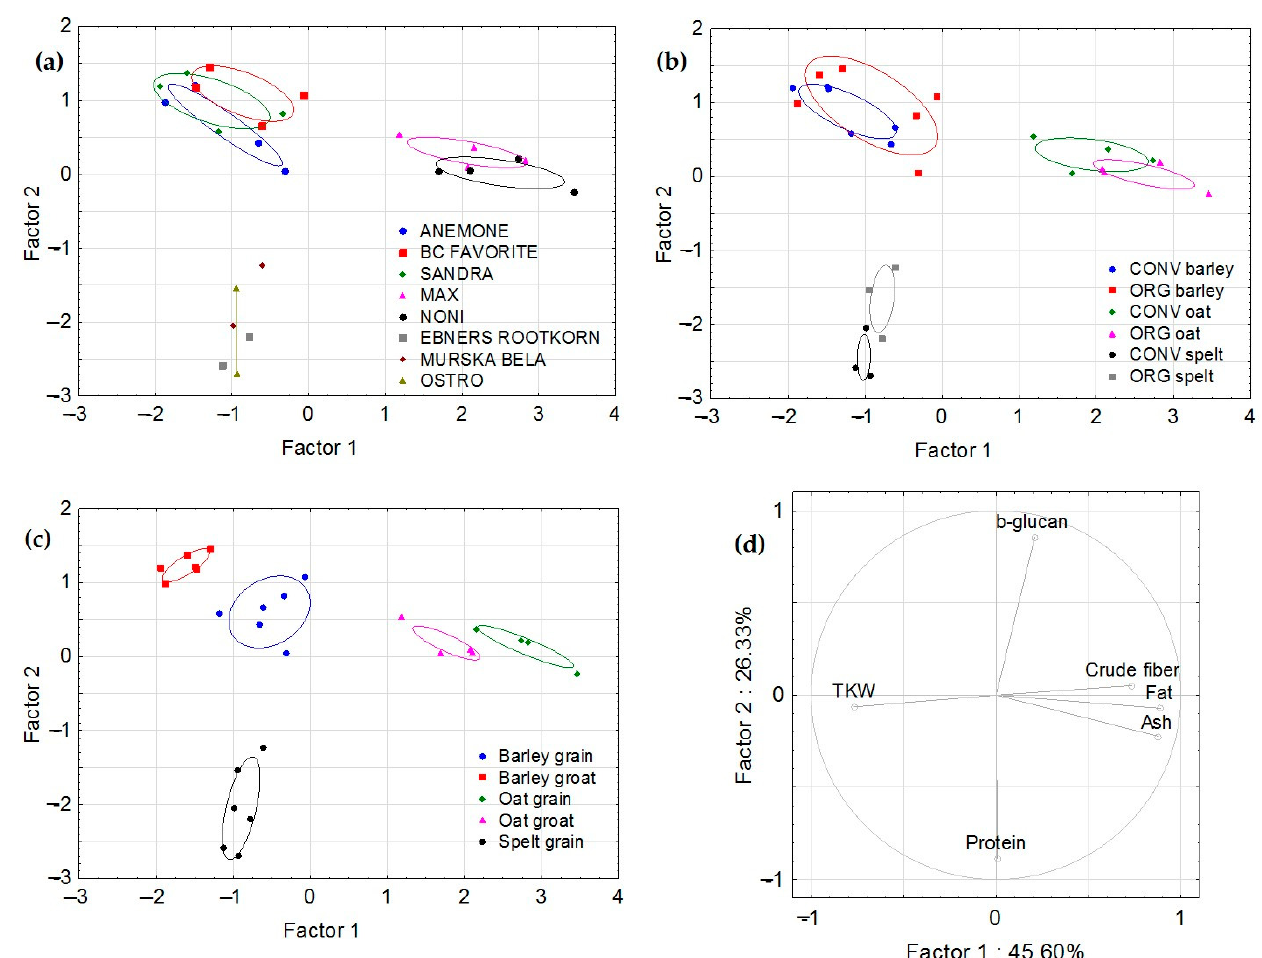
Figure 4. Principal component analysis plots based on six compositional grain characteristics (thou- sand kernel weight (TKW) and β -glucan, protein, crude fibre, fat, and ash contents) grouped by ( a ) cereal variety, ( b ) field management, and ( c ) grain fractions. ( d ) Discriminant loading plot. Factor 1 is determined by the fat (0.8889), ash (0.8786), and crude fibre (0.7332) contents and TKW ( − 0.7693), while Factor 2 is determined by the protein ( − 0.8858) and β -glucan (0.8562) contents.